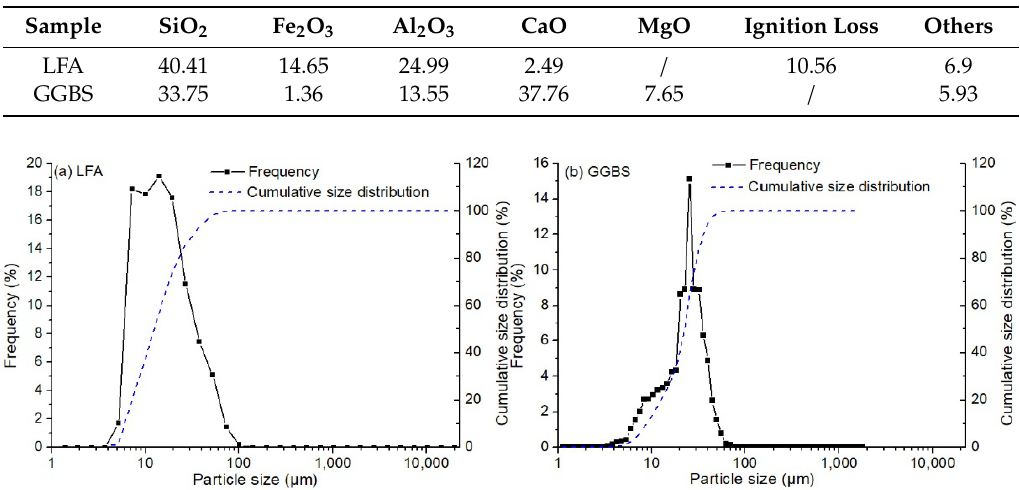
Figure 1. Particle size distribution of ( a ) landfilled fly ash (LFA), and ( b ) GGBS.